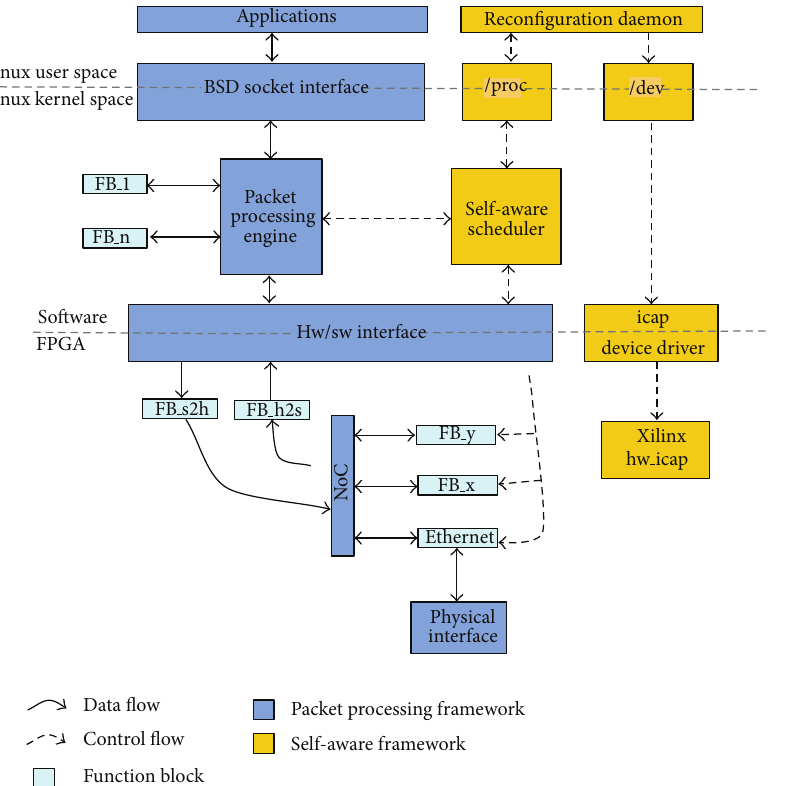
Figure 5: Overall system allowing for a self-aware hardware/software